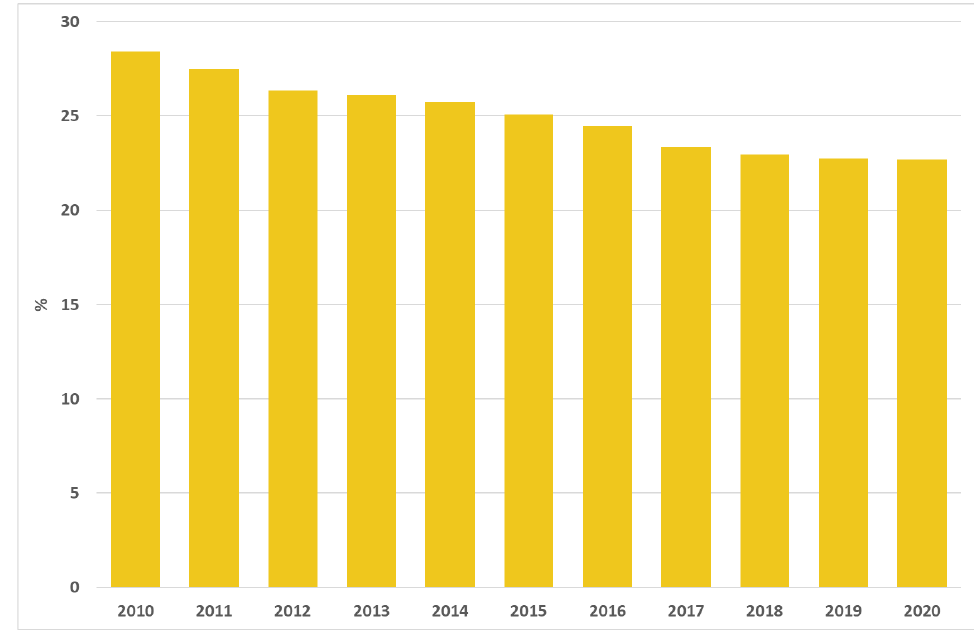
Figure 7. Proportion of primary caesarean deliveries. Italy, 2010–2020.